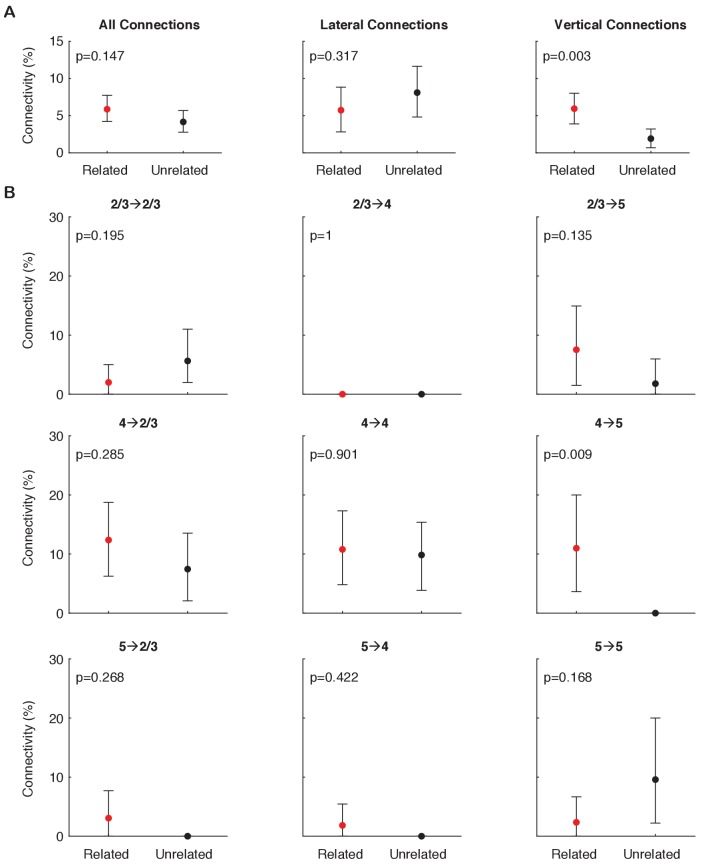
Comparison of connectivity between clonally related neurons and distance-matched controls.(A) Connectivity for all connections (left panel); only lateral, within-layer connections (middle panel); or only vertical, across-layer connections (right panel). (B) Connectivity for each layer-defined connection type tested. Pre- and post-synaptic location of the cell bodies is designated above each plot. In A and B, error bars are 95% coverage intervals computed by resampling (see Methods); p-values are two-sided and computed by resampling (see Methods). Related to Figure 5.